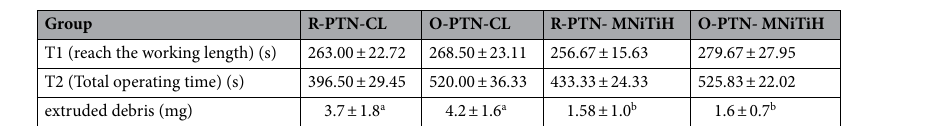
Figure 3. Representative samples of reconstructed 3D micro-CT images from each group ( a ) R-PTN-CL Group ( b ) R-PTN- MNiTiH Group ( c ) O-PTN-CL Group ( d ) O-PTN- MNiTiH Group) showing the filling materials (pink) after obturation (I), the remaining filling materials (pink) after retreatment with different methods (II), and the canal surface without covering by RFMs (green) and covered by RFMs (red).